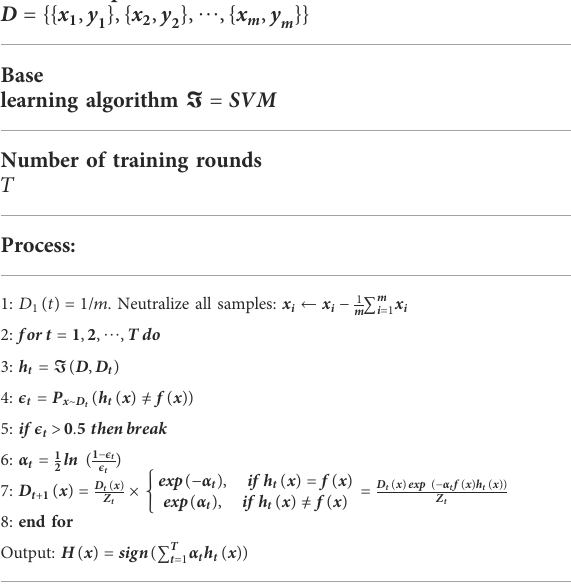
TABLE 2 Pseudo-code of the ground fault classi fi cation learning model based on AdaBoost proposed by Shu et al. (2019). Input: grounding fault feature sample